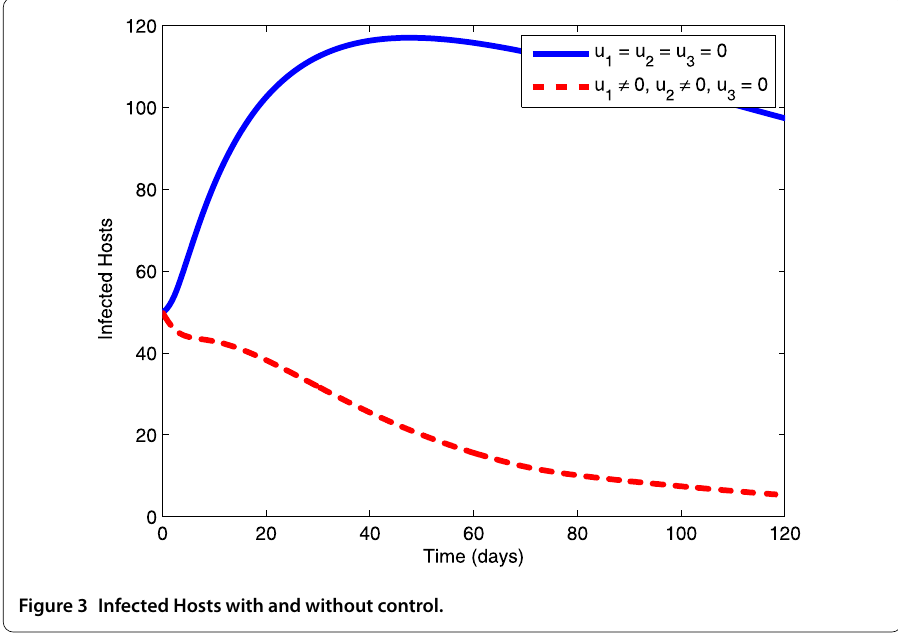
Figure 3 Infected Hosts with and without control.